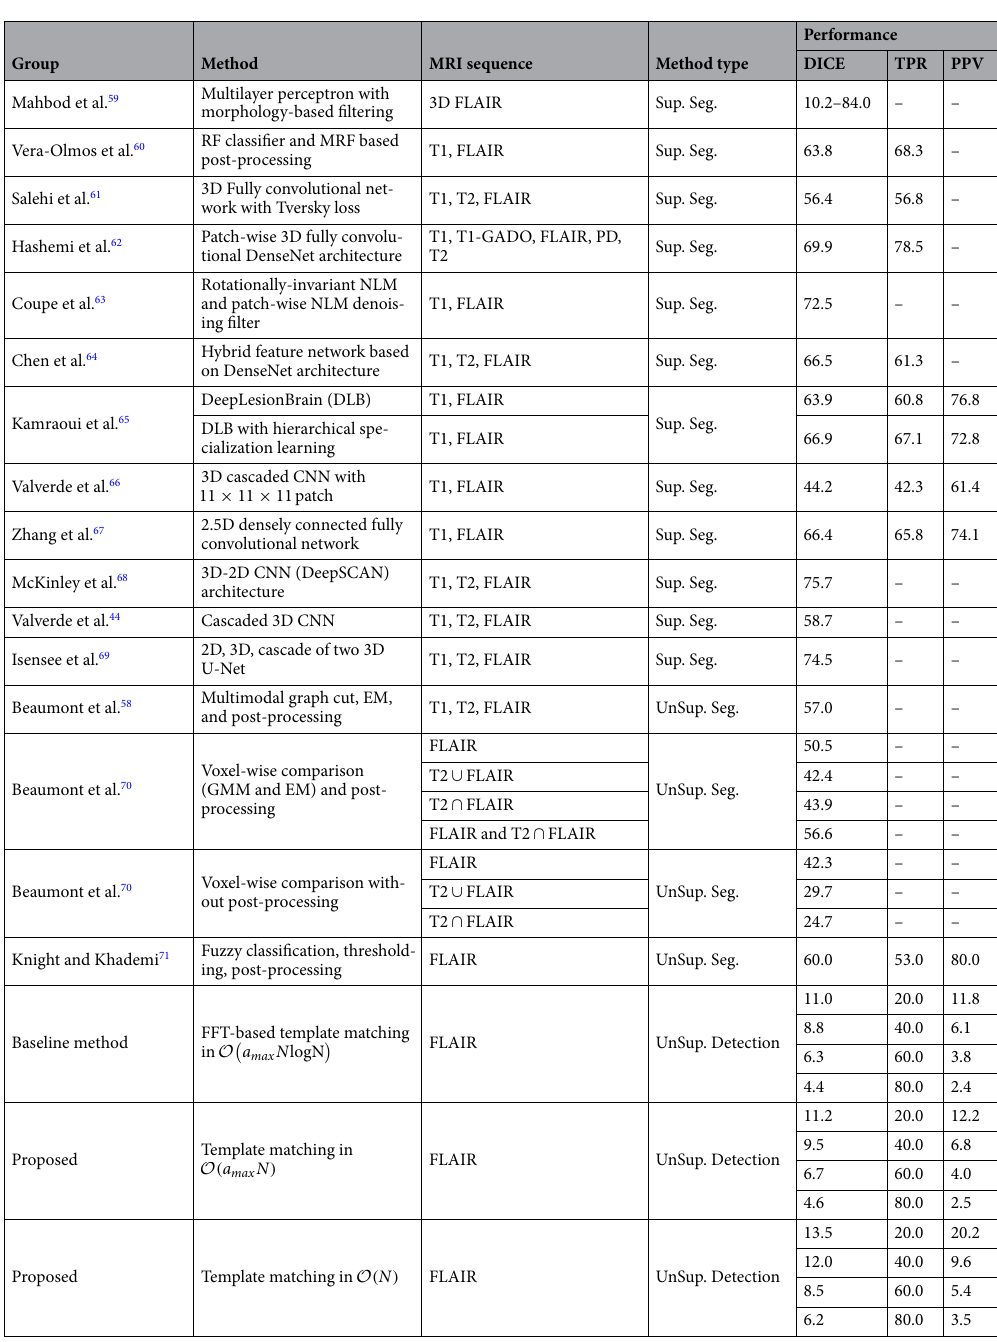
Table 4. Comparison of the existing state-of-the-arts on MICCAI MSSEG 2016 Training Data 65,68 . (TPR = TPF; PPV = 1 −